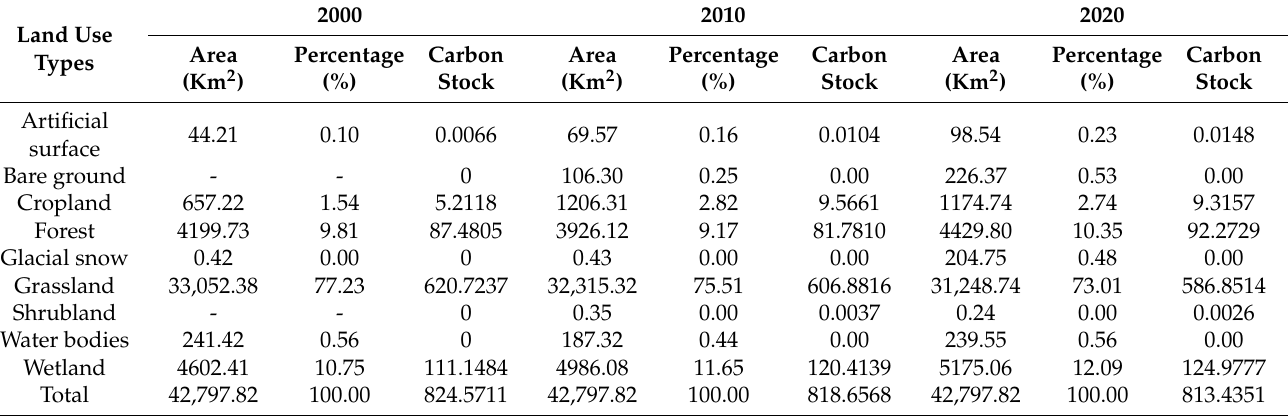
Figure 4. Sensitivity of carbon density of various carbon pools to total carbon density. Table 3. Land use type changes and carbon stocks in the Zoig ê alpine grassland area from 2000 to 2020 (unit: area-square kilometers; share-%;